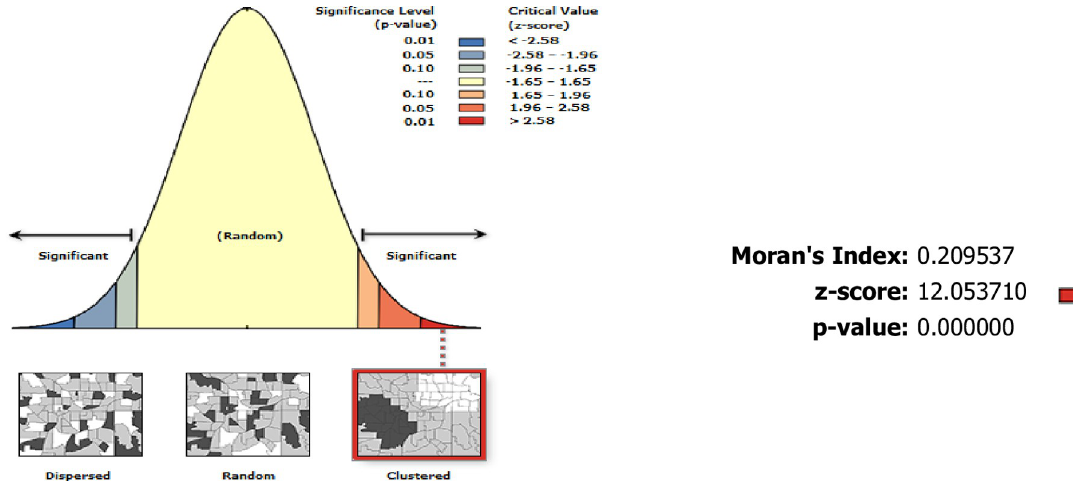
Fig 4. Global Moran’s I spatial autocorrelation